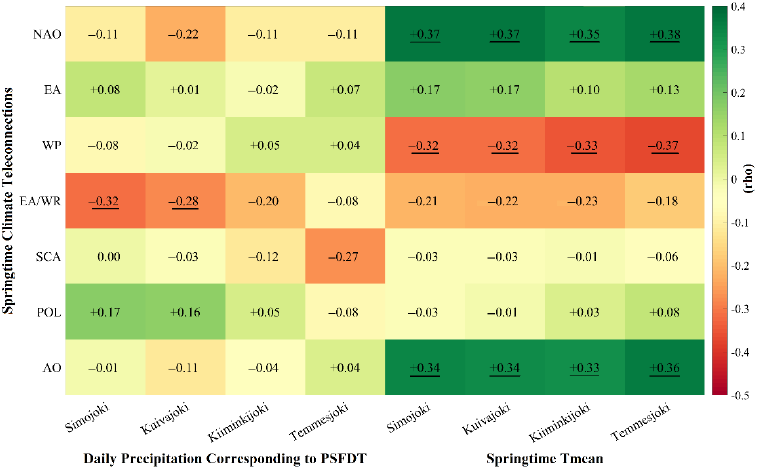
Figure 7. The Spearman ’ s rank correlations (rho) of springtime climate teleconnections with daily precipitation corresponding to the PSFD as well as with springtime Tmean in all the Simojoki, Kuivajoki, Kiiminkijoki, and Temmesjoki rivers across northern Finland during 1967 – 2011. The underlined values show statistically significant ( p < 0.05) correlations. The correlations of PSFDMs in the Simojoki and the Kuivajoki (rho = 0.84) were stronger than in the Kuivajoki and the Kiiminkijoki (rho = 0.72) as well as in the Kiiminki- joki and the Temmesjoki (rho = 0.64) (Figure 8). Similar relationships were found in the PSFDTs of natural rivers studied across northern Finland, with rho = 0.67 – 0.97 (Figure 8). The Kiiminkijoki and the Temmesjoki showed the highest correlation (rho = +0.92) be- tween daily precipitation time series corresponding to the PSFDTs (Figure 8). Spring Tmean variability was strongly similar over the basin of all the natural rivers studied, with rho = 0.97 – 0.99 (Figure 8). The negative effects of spring Tmean were stronger on the PSFDT in the Simojoki (rho = −0 .48) and the Kuivajoki (rho = −0 .45) rivers than in the Kiiminkijoki (rho = −0 .34) and Temmesjoki (rho = −0 .26) rivers (Figure 8). Figure 8. The Spearman ’ s rank correlations (rho) among peak spring flood discharge magnitude (PSFDM). PSFD timing (PSFDT), PSFDT’s corresponding daily precipitation (Daily P), and